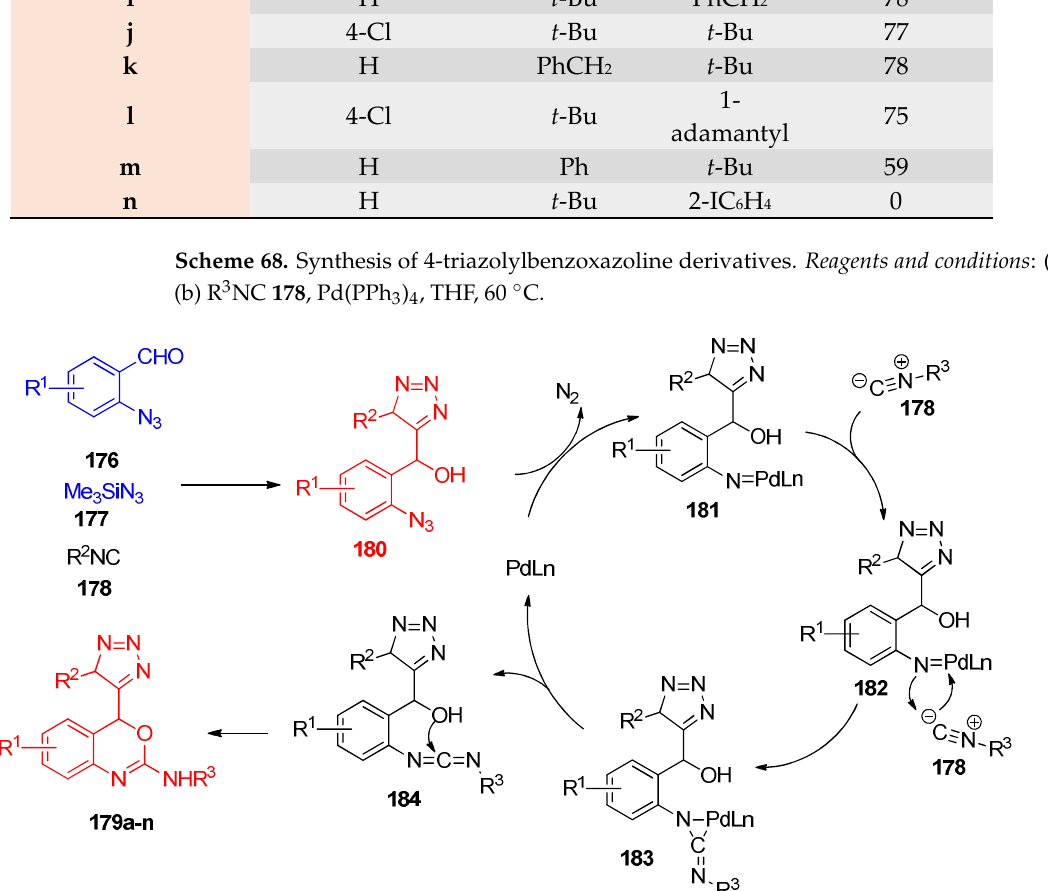
Scheme 68. Synthesis of 4-triazolylbenzoxazoline derivatives. Reagents and conditions : (a) CH 2 Cl 2 ; (b) R 3 NC 178 , Pd(PPh 3 ) 4 , THF, 60